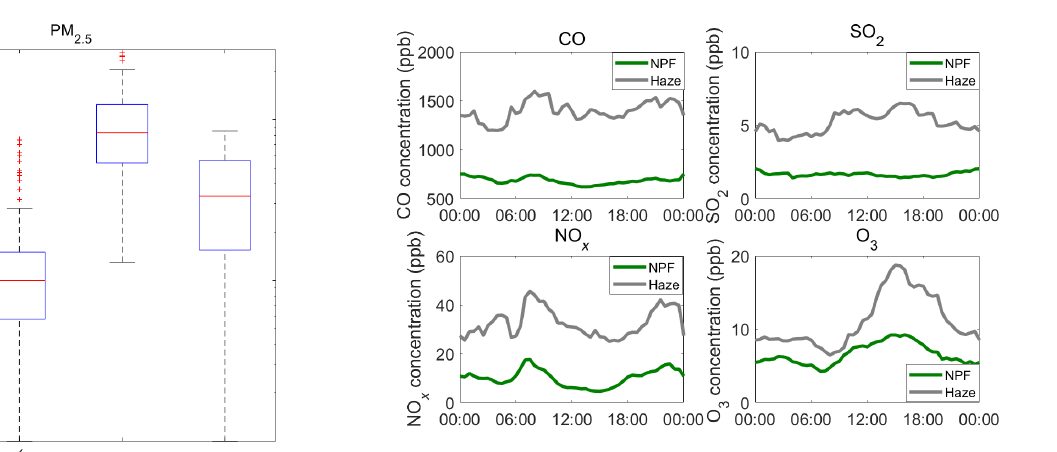
Figure 6. Diurnal variation of trace-gas (CO, SO 2 , NO x and O 3 separately) mixing ratios on the NPF event days (green lines) and haze days (gray lines) separately. The time resolution was 30min for every data point. Every data point here represents the median of all data at the same time of the day.